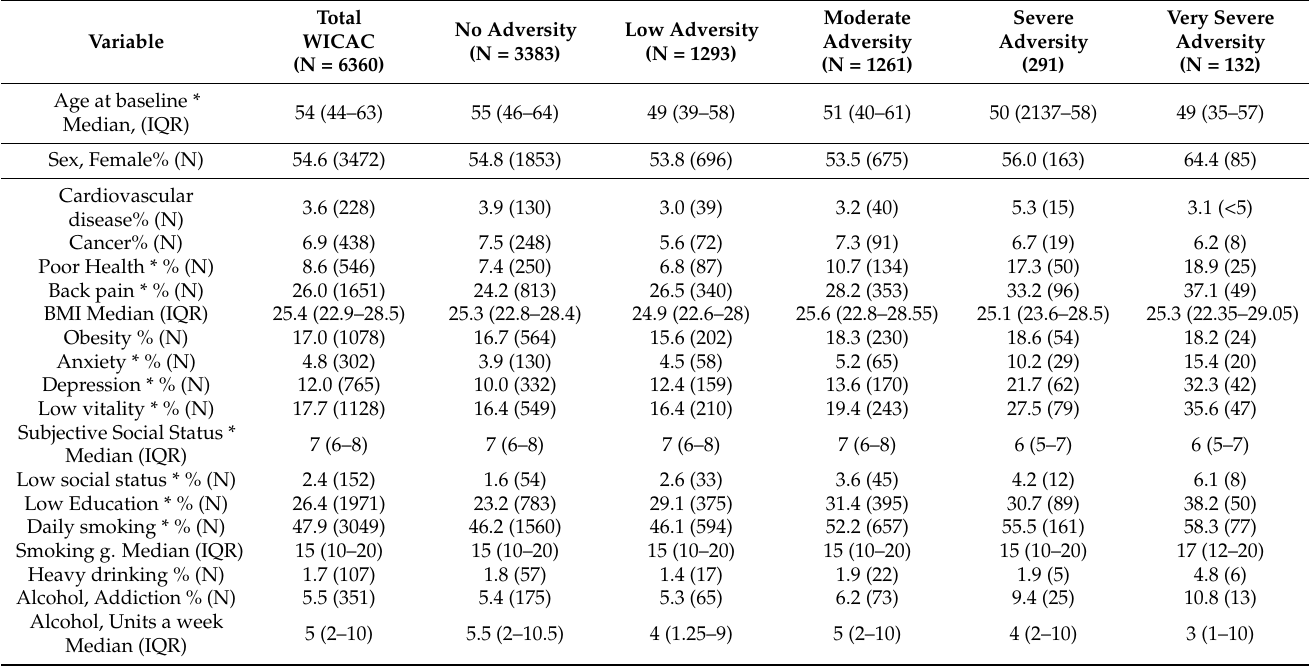
Table 3. Population Characteristics divided into index categories.